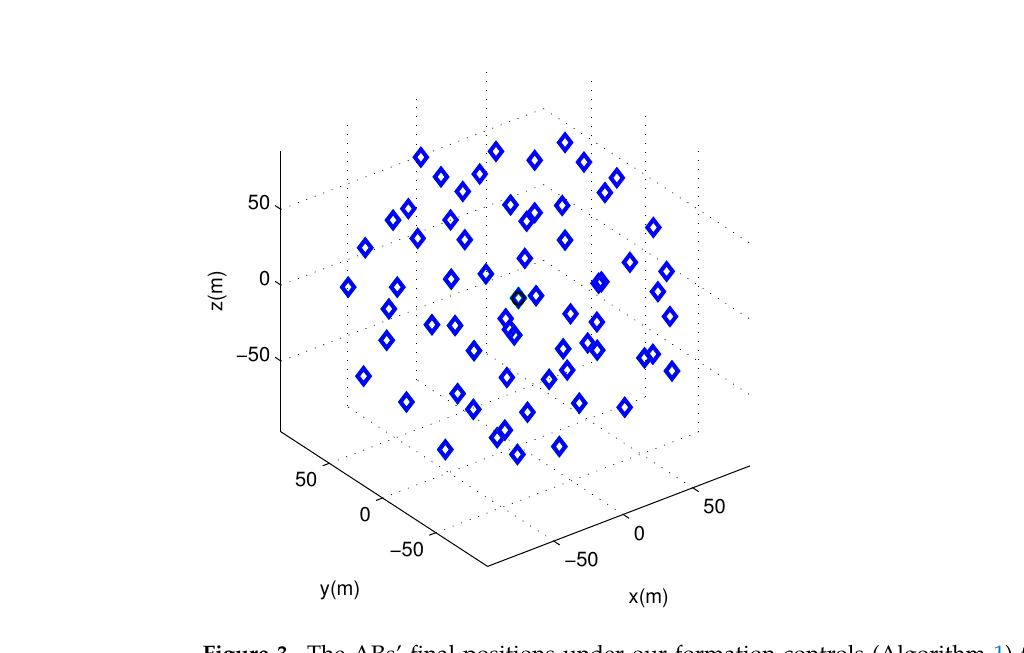
Figure 3. The ARs’ final positions under our formation controls (Algorithm 1) for covering the user-specified sphere shape ( r sc = 50